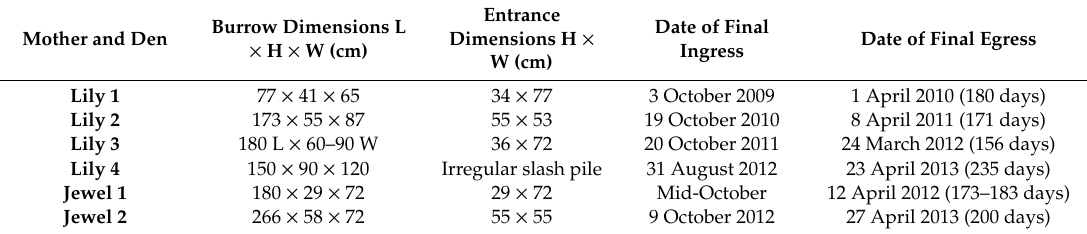
Table 1. Den information for the six denning events.